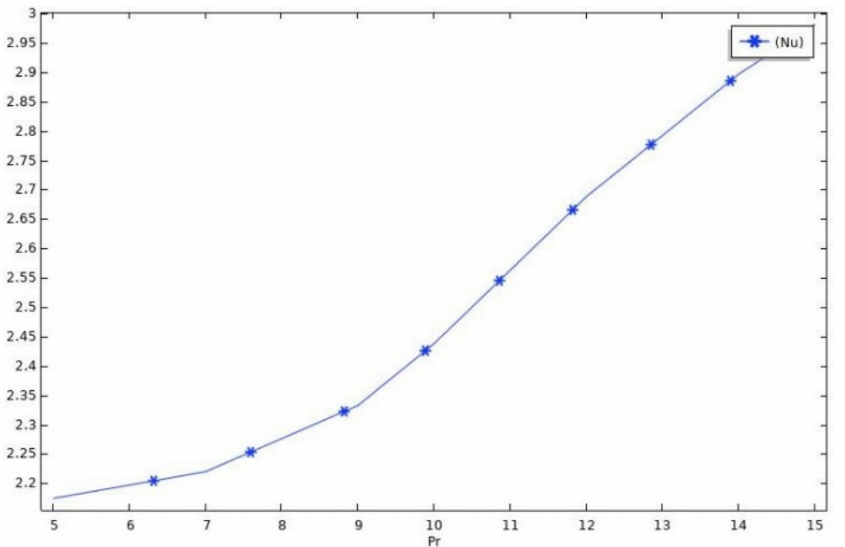
Figure 11. Nusselt number graph against varying ( Pr )